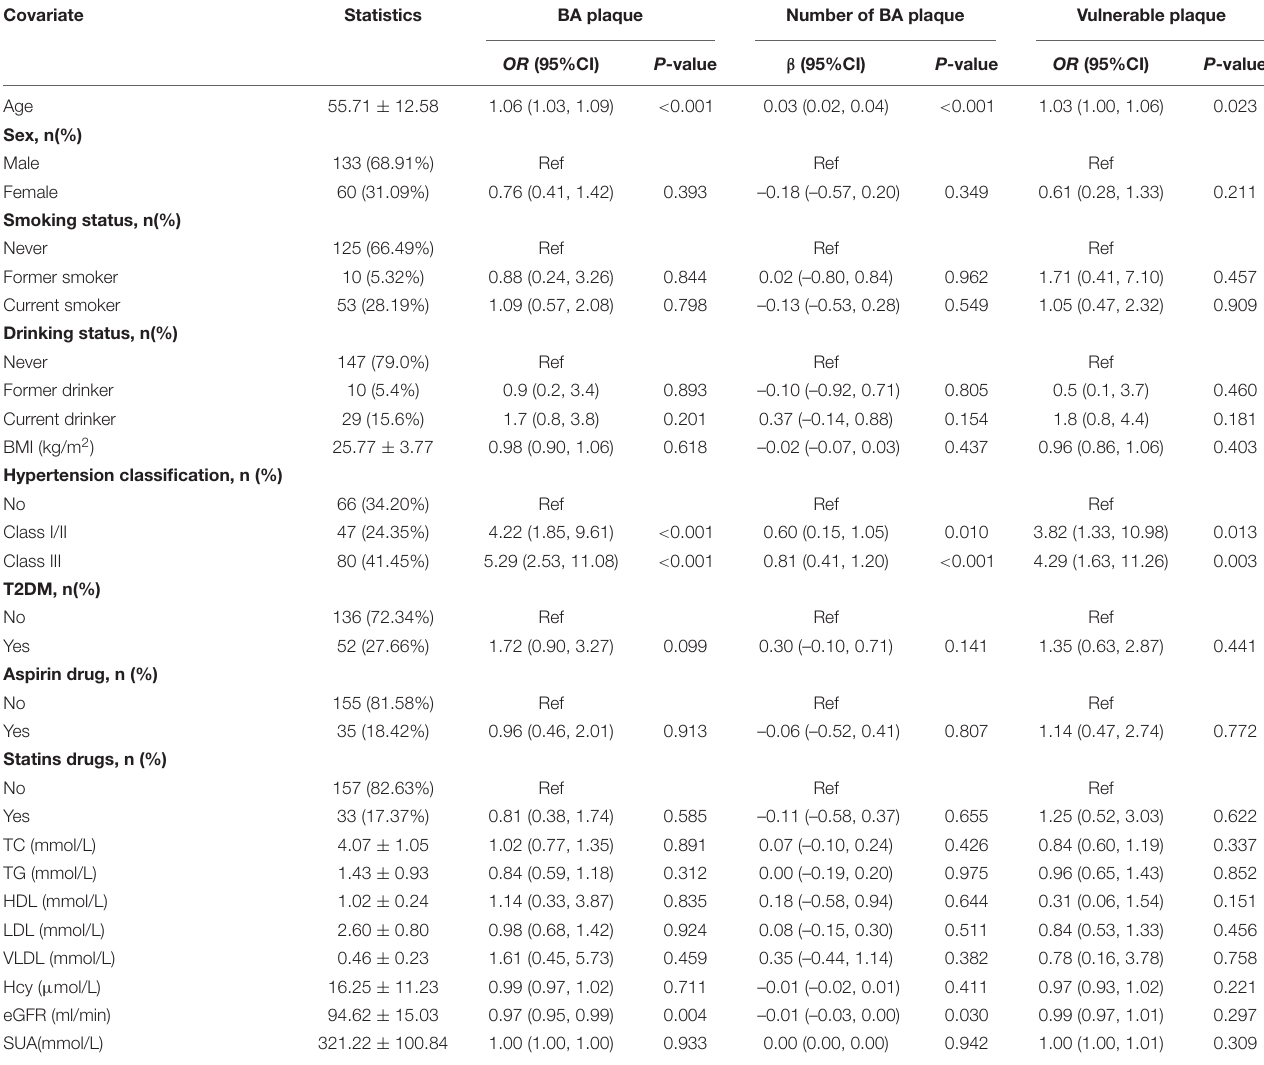
TABLE 1 | Univariate analyses for BA plaque and vulnerable plaque. Covariate Statistics BA